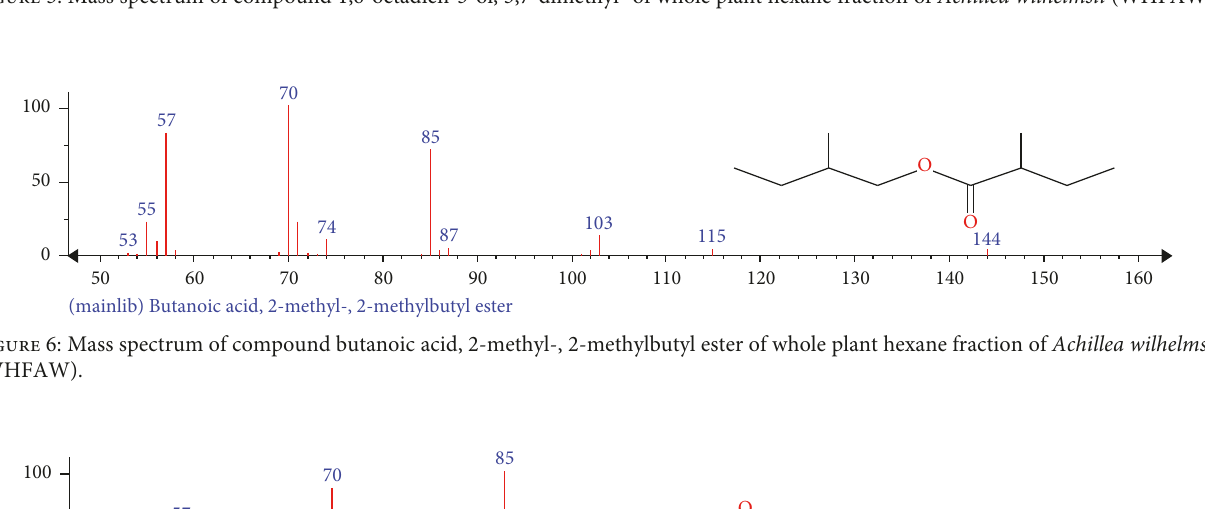
Figure 5: Mass spectrum of compound 1,6-octadien-3-ol, 3,7-dimethyl- of whole plant hexane fraction of Achillea wilhelmsii (WHFAW).